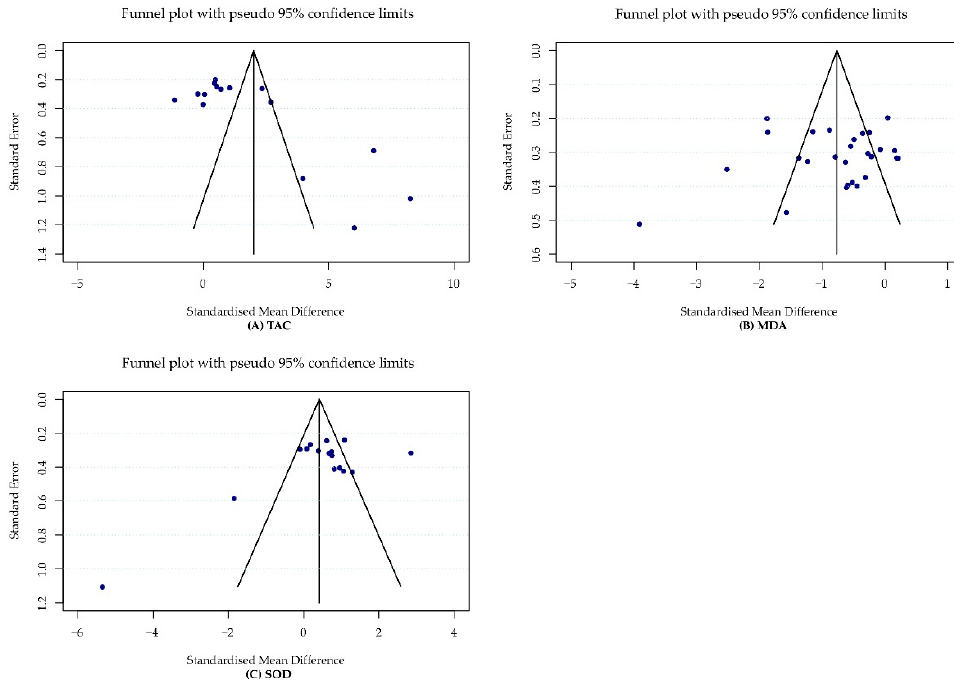
Figure 5. Funnel plots representing publication bias in the included studies relevant to the effect of CoQ10 supplementation on ( A ) TAC, ( B ) MDA and ( C ) SOD. CoQ10 supplementation on ( A ) TAC, ( B ) MDA and ( C )